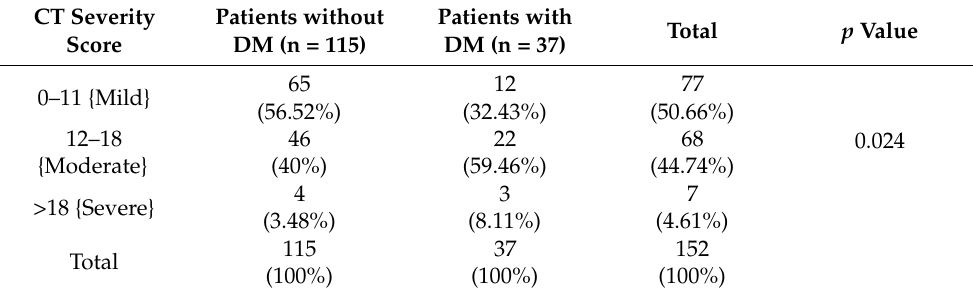
Table 4. Multivariate logistic regression to identify significant risk factors for moderate/severe CTSS.